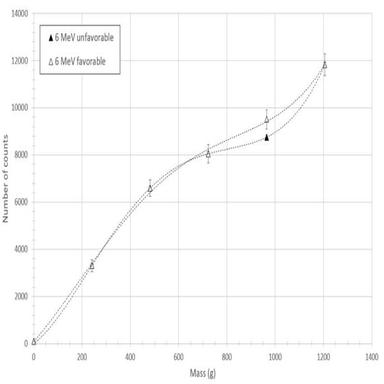
Delayed neutron counts as a function of the depleted uranium mass, obtained at 6 MeV.